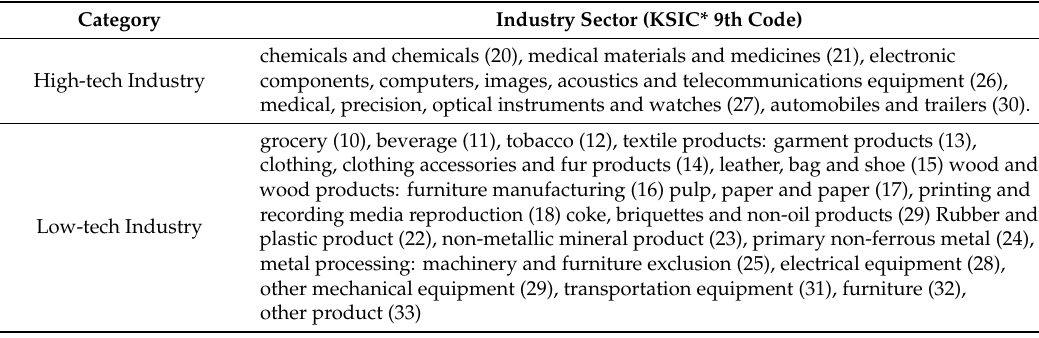
Figure 3. Chart of determination for research target. Table 2. Classification of manufacturing industry in Korea.